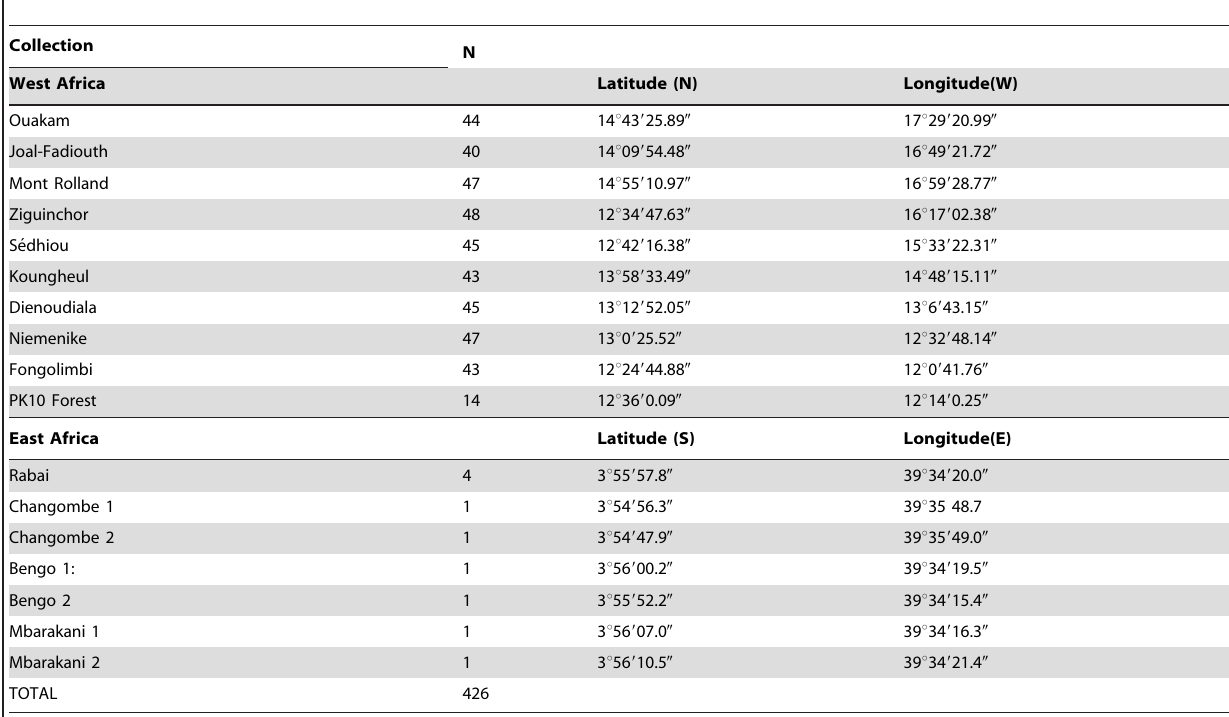
Table 2. Location and samples sizes of Aedes aegypti s.l. from 10 collections in Senegal and 7 locations in Kenya*.